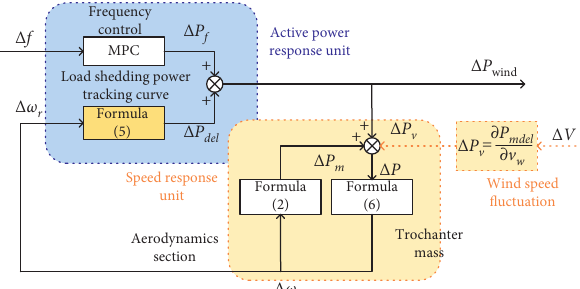
Figure 1: Power tracking curve of the fan under load reduction operation.